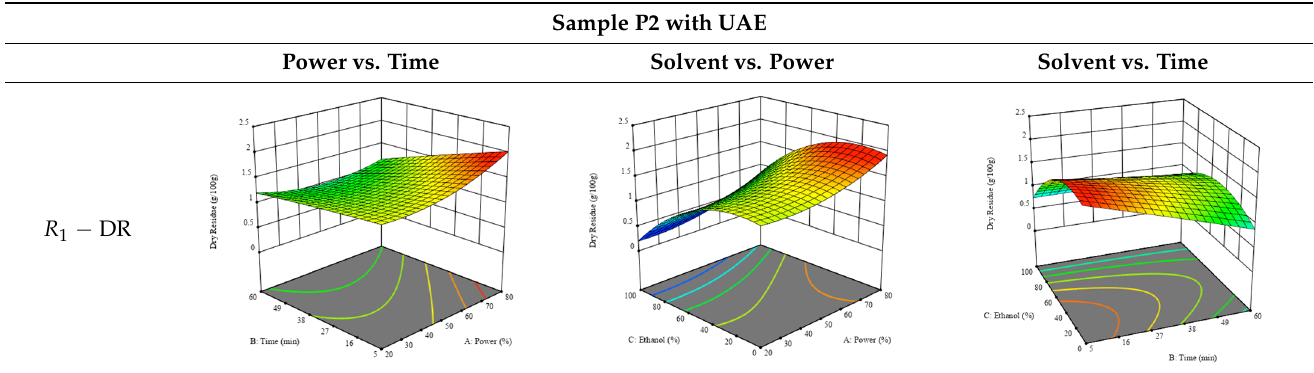
Table 8. 3D response charts of the ultrasound-assisted extraction (UAE) of ‘Voutirato’ peel (P2) at the optimal values.